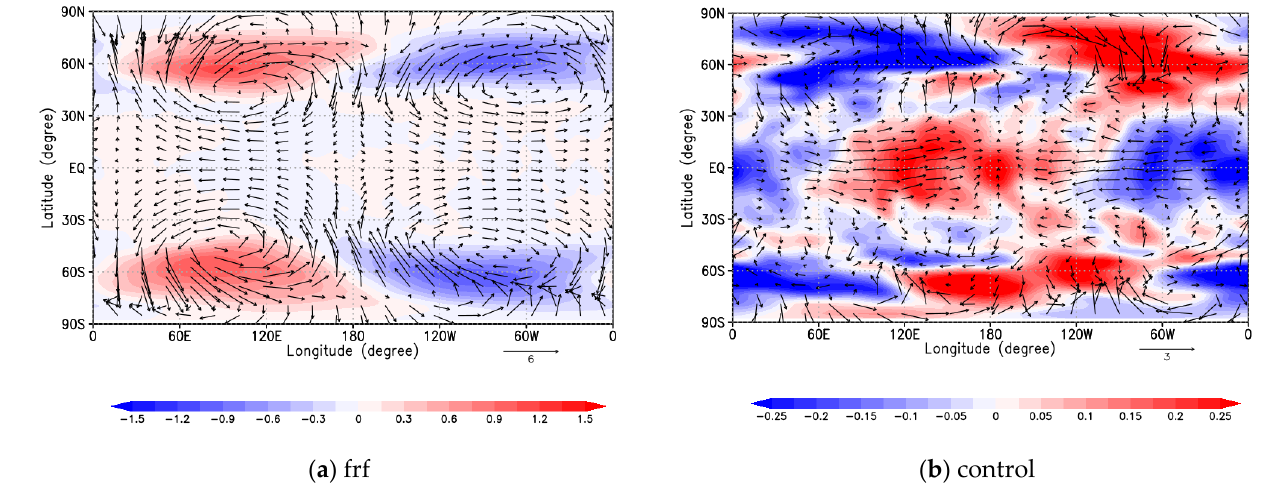
Figure 4. Longitude – latitude cross-sections of the composite means of horizontal wind (m/s; vector) and temperature (K; color) deviations from zonal averages at 70 km for the ( a ) frf and ( b ) control cases. Each field is averaged along with periods of 5 and 4 Earth days for the frf and control cases to extract the Rossby and Kelvin waves, respectively.